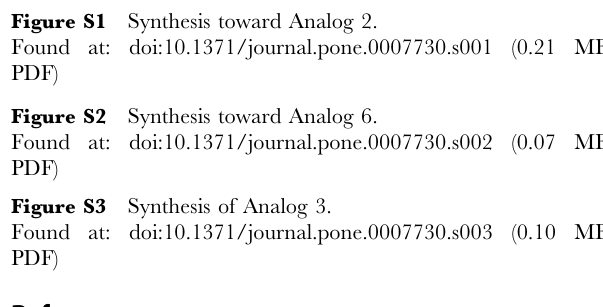
Figure S3 Synthesis of Analog 3.